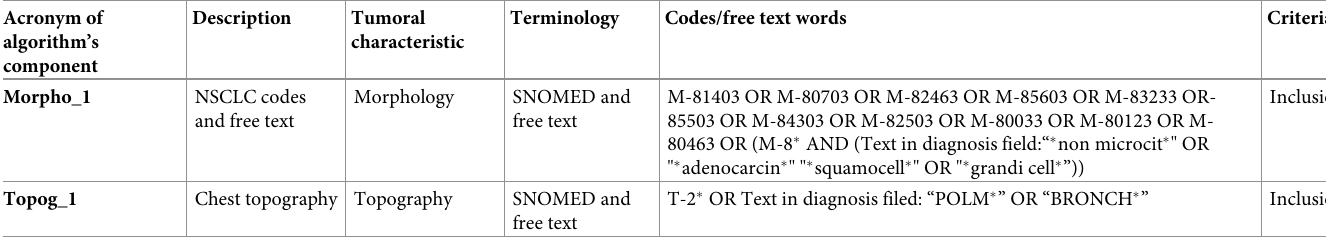
Table 1. Components of the first version of the algorithm used for the identification of NSCLC cases in the pathology registry of Siena �